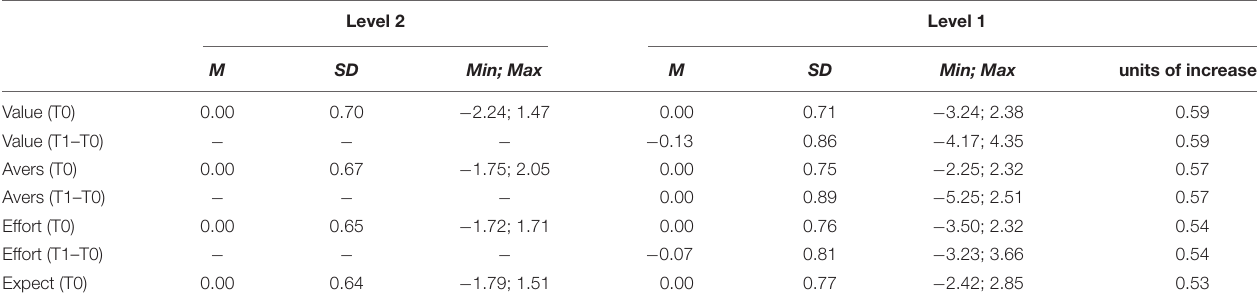
TABLE 2 | Descriptive statistics for standardized variables (subjective task-specific appraisals) used as predictors in the logistic two-level regression analyses at Level 1 (task-specific ratings; n = 501) and Level 2 (person-mean ratings; N = 75 participants). Level